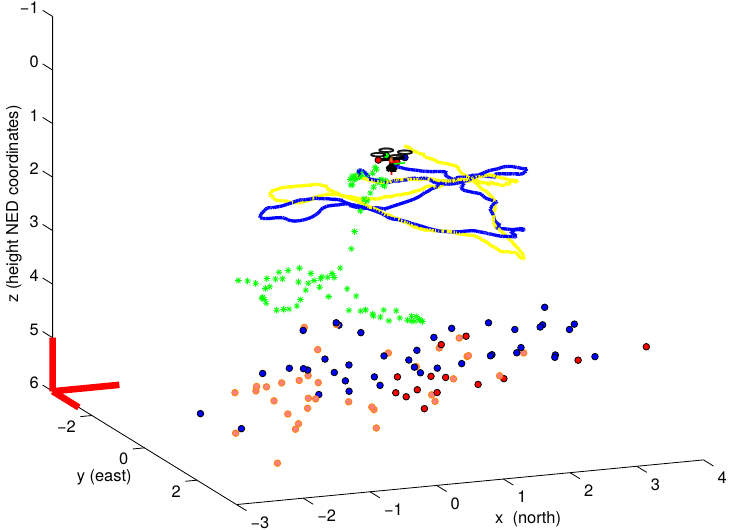
Figure 13. 3D plot of the estimated map and trajectory obtained in visual-based navigation mode. Considering the trajectory obtained by the P4P visual technique as a reference, it can be clearly appreciated that GPS is unreliable to estimate position when fine manoeuvres are